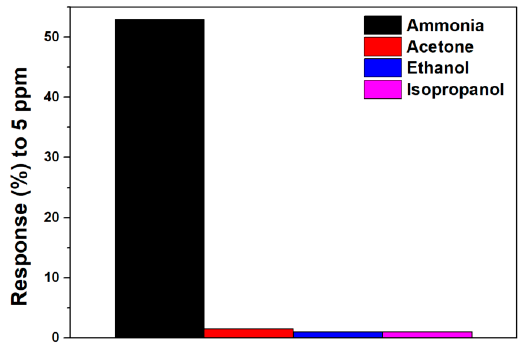
Figure 12. Selectivity test: Response of PPy sensors after reduction treatments in Na 2 SO 3 10 wt% solution in demineralized water to 5 ppm ammonia, acetone, ethanol, and isopropanol.